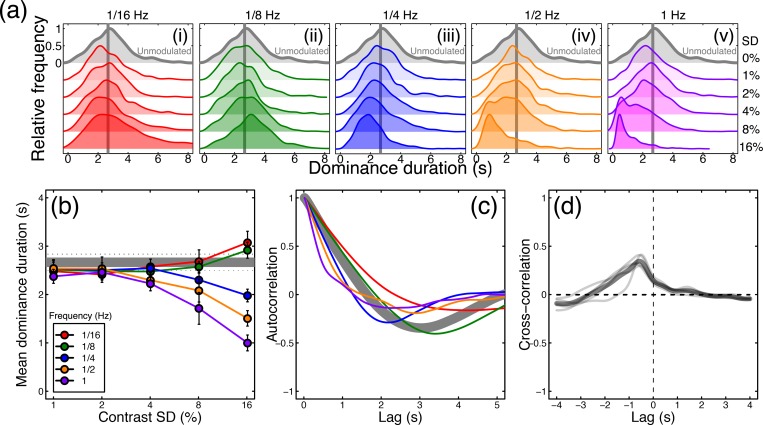
Traditional rivalry measures for all conditions, averaged (or pooled) across all participants (N = 5).Panel (a) shows histograms of pooled dominance durations at five temporal frequencies (i-v) and a range of contrast levels (standard deviations of 0–16% contrast, increasing down each plot). The grey histogram, duplicated in each plot, shows the baseline condition with no contrast modulation. For low temporal frequency, high contrast modulations, there were more very long dominance periods (the positive skew of the red histogram increases). For high temporal frequency, high contrast modulations there were more short dominance periods, and the histograms shifted left. Panel (b) shows mean dominance durations for all conditions, plotted as a function of modulation contrast. The grey horizontal line shows the baseline (no modulation) condition. Error bars (and dotted lines) show ±1SE across participants. Panel (c) shows autocorrelation functions (e.g. the correlation between a participant’s percept at a given moment, as in Fig 1C, with their percept at subsequent moments) averaged across participants for the baseline condition (grey curve) and the highest contrast modulation at each temporal frequency (curves, see panels a,b for colour legends). Panel (d) shows the cross correlation between the participants’ responses and the difference in noise modulations at the highest modulation contrast, averaged across all modulation frequencies. The thin grey lines denote individual participants and the thick black line is the average.